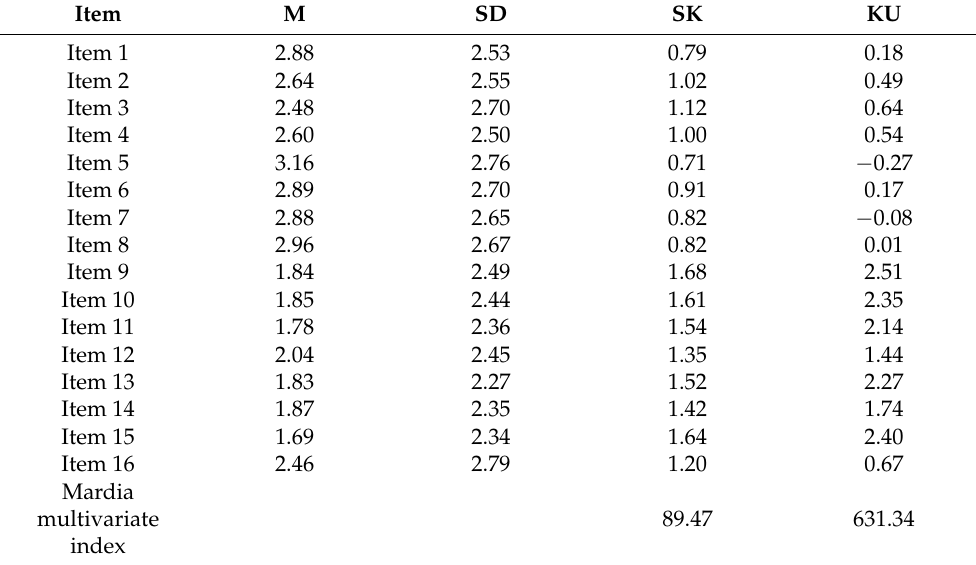
Table 2. Skew and kurtosis values of the PASTAS-M questionnaire items. Total sample.